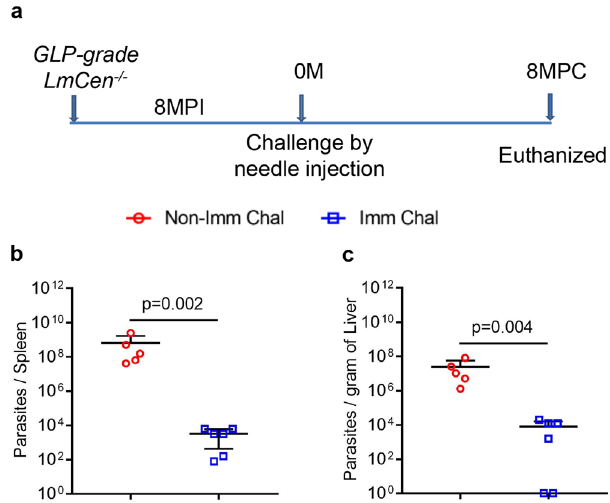
Fig. 6 GLP-grade LmCen − / − immunization confers long-term protection against fatal L. donovani infection in hamsters. a Schematic representation of experimental plan to determine the long-term protective ef fi cacy of LmCen − / − parasites against L. donovani infection through needle injection. b ,